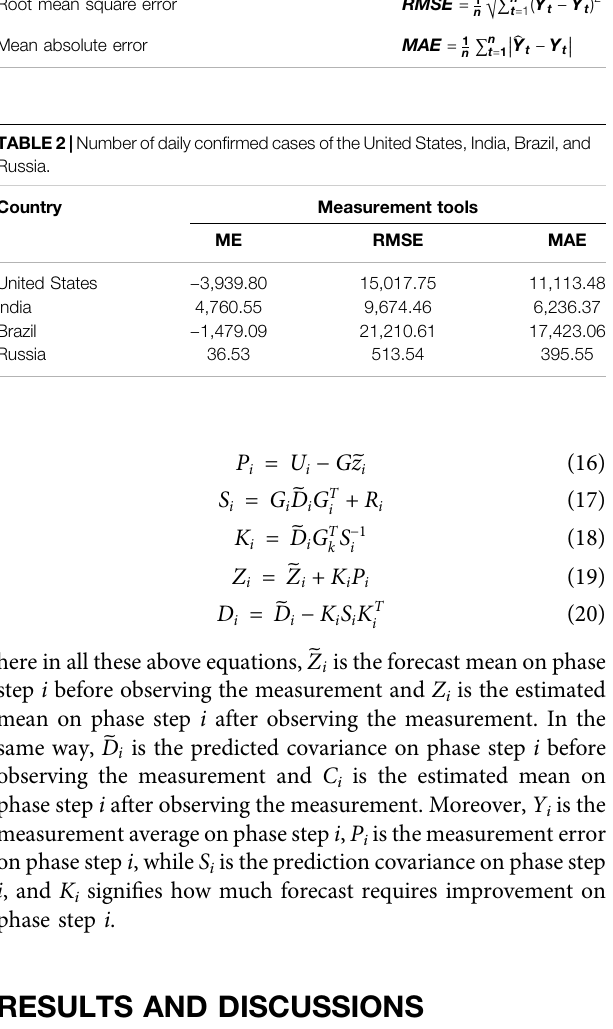
TABLE 3 | Number of daily death cases in the United States, India, Brazil, and Russia. Country Measurement tools